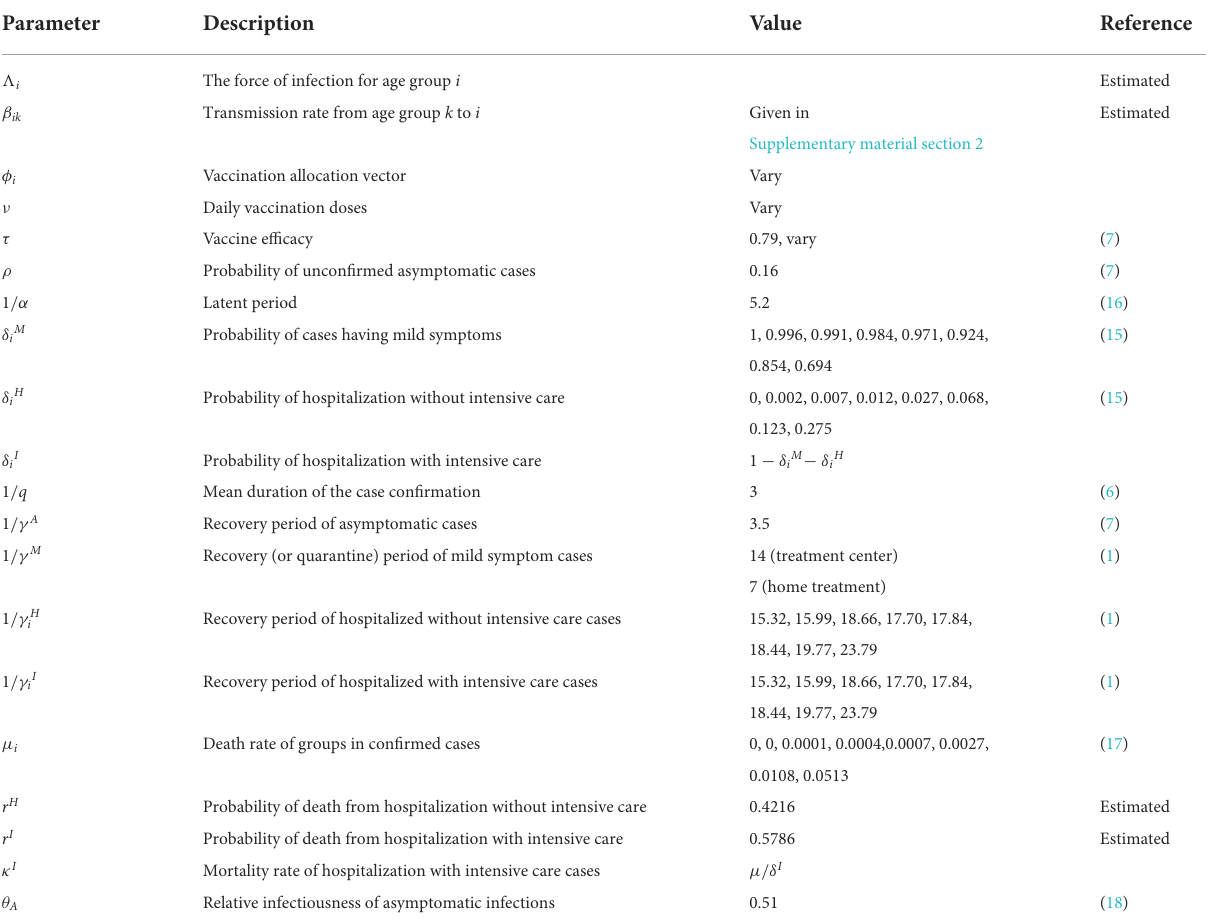
TABLE 1 Parameter definitions and baseline values used in numerical